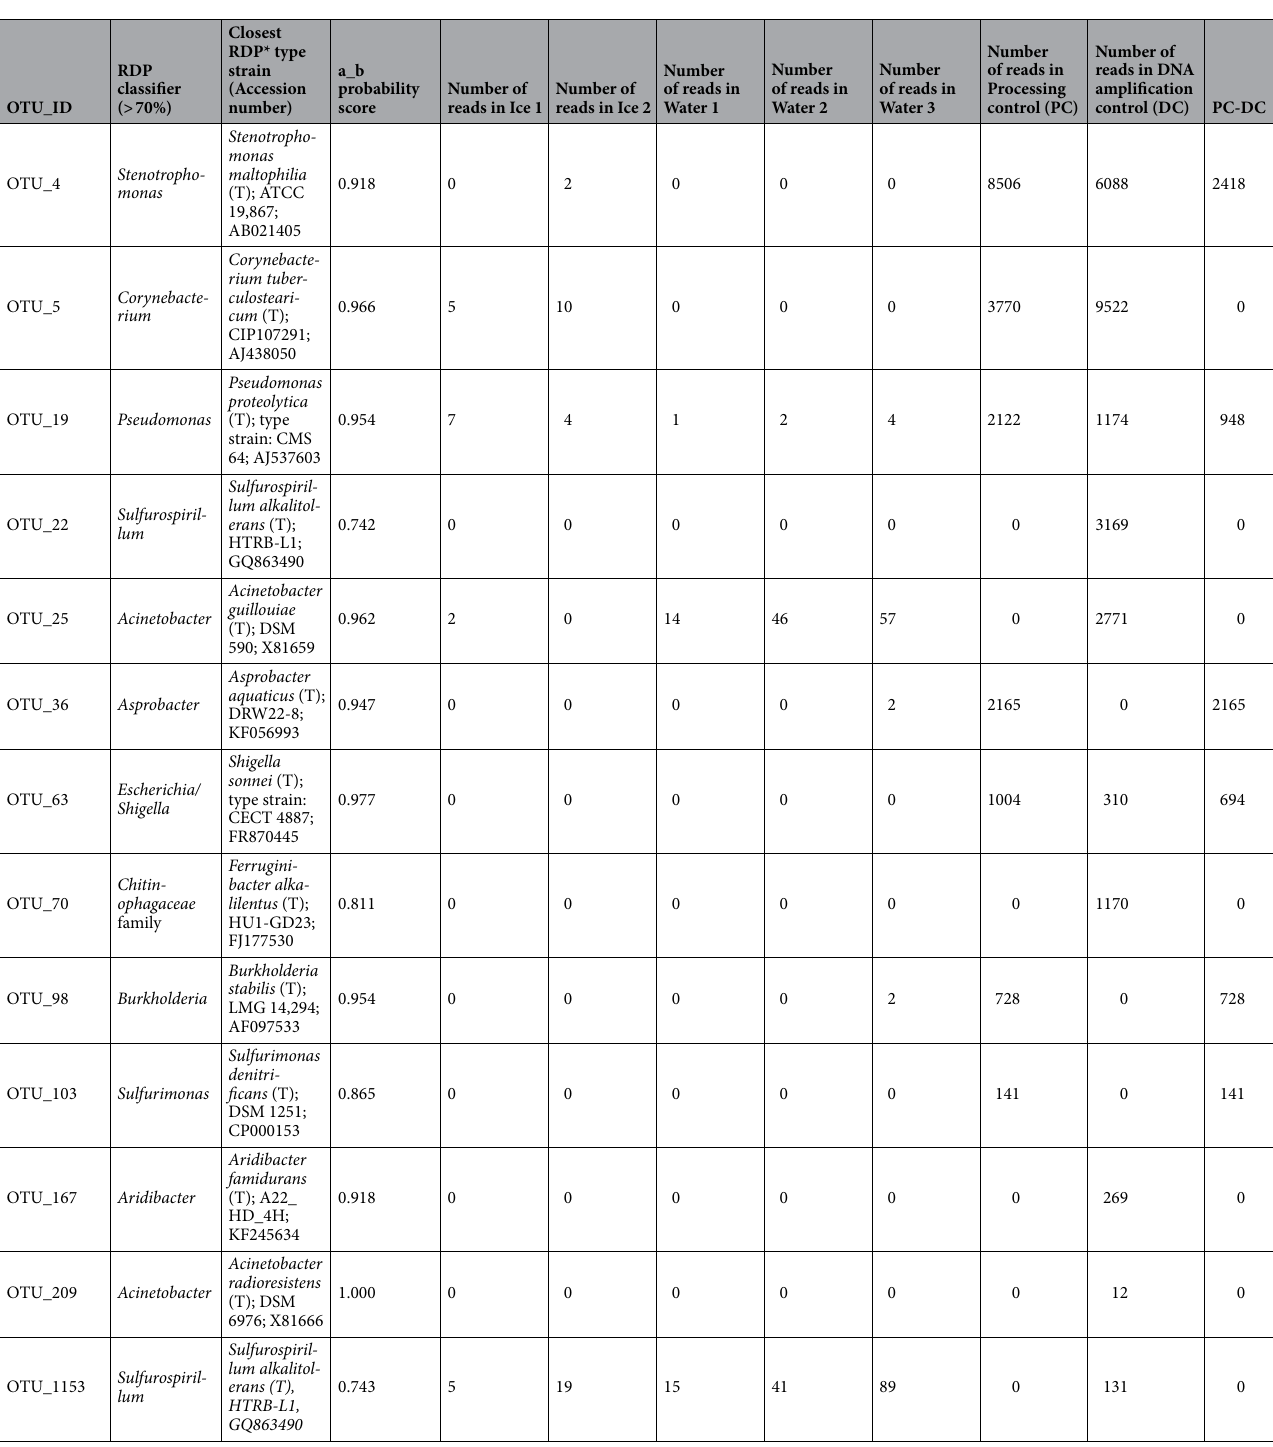
Table 3. List of all OTUs retrieved in the processing control (PC) and DNA extraction control (DC). The OTU’s abundance (number of reads) are presented from environmental ice meltwater (Ice 1, Ice 2), environmental interface water (Water 1, Water 2, Water 3), PC, DC, and PC-DC (removing PC shared OTUs with DNA-extraction control remaining only contaminant OTUs exclusive from the processing control). The OTUs are shown classified at the genus level based on the RDP classifier (OTUs with scores > 70% confidence threshold were considered classified at the genus level). The closest type strain on RDP represents the closest type species at the RDP database and respective closeness score (a_b probability score). Note that OTU 209 was identified as species Acinetobacter